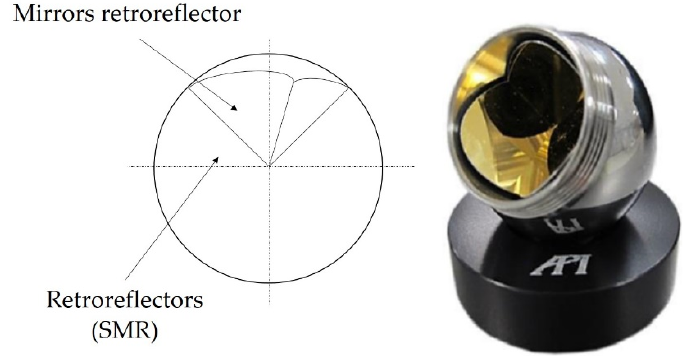
Figure 2. Construction of a laser tracker retroreflector.